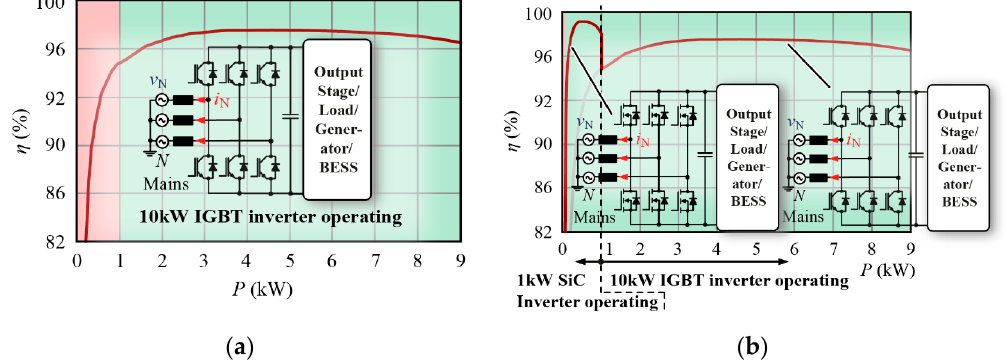
Figure 1. Example efficiency curves of ( a ) a standard 3-phase 10 kW IGBT inverter and ( b ) a combination of both, SiC and IGBT inverter where a 1 kW SiC inverter is operating during load conditions of 0 to 1 kW and the 10 kW Si–IGBT inverter for any mode >1 kW.